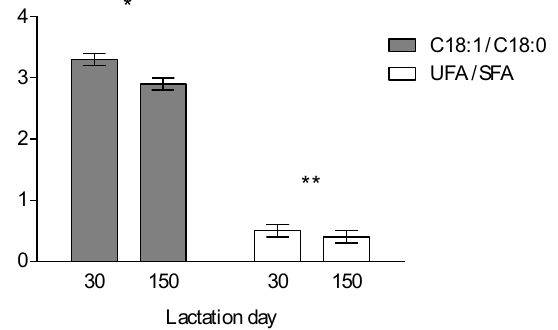
Figure 1. Ratio of C18:1 / C18:0 and UFA / SFA (unsaturated fatty acids / saturated fatty acids) in the milk of Holstein cows around days 30 and 150 of lactation; ∗ significant difference between sam- pling periods at P < 0 . 05; ∗∗ significant difference between sam- pling periods at P < 0 . 01.